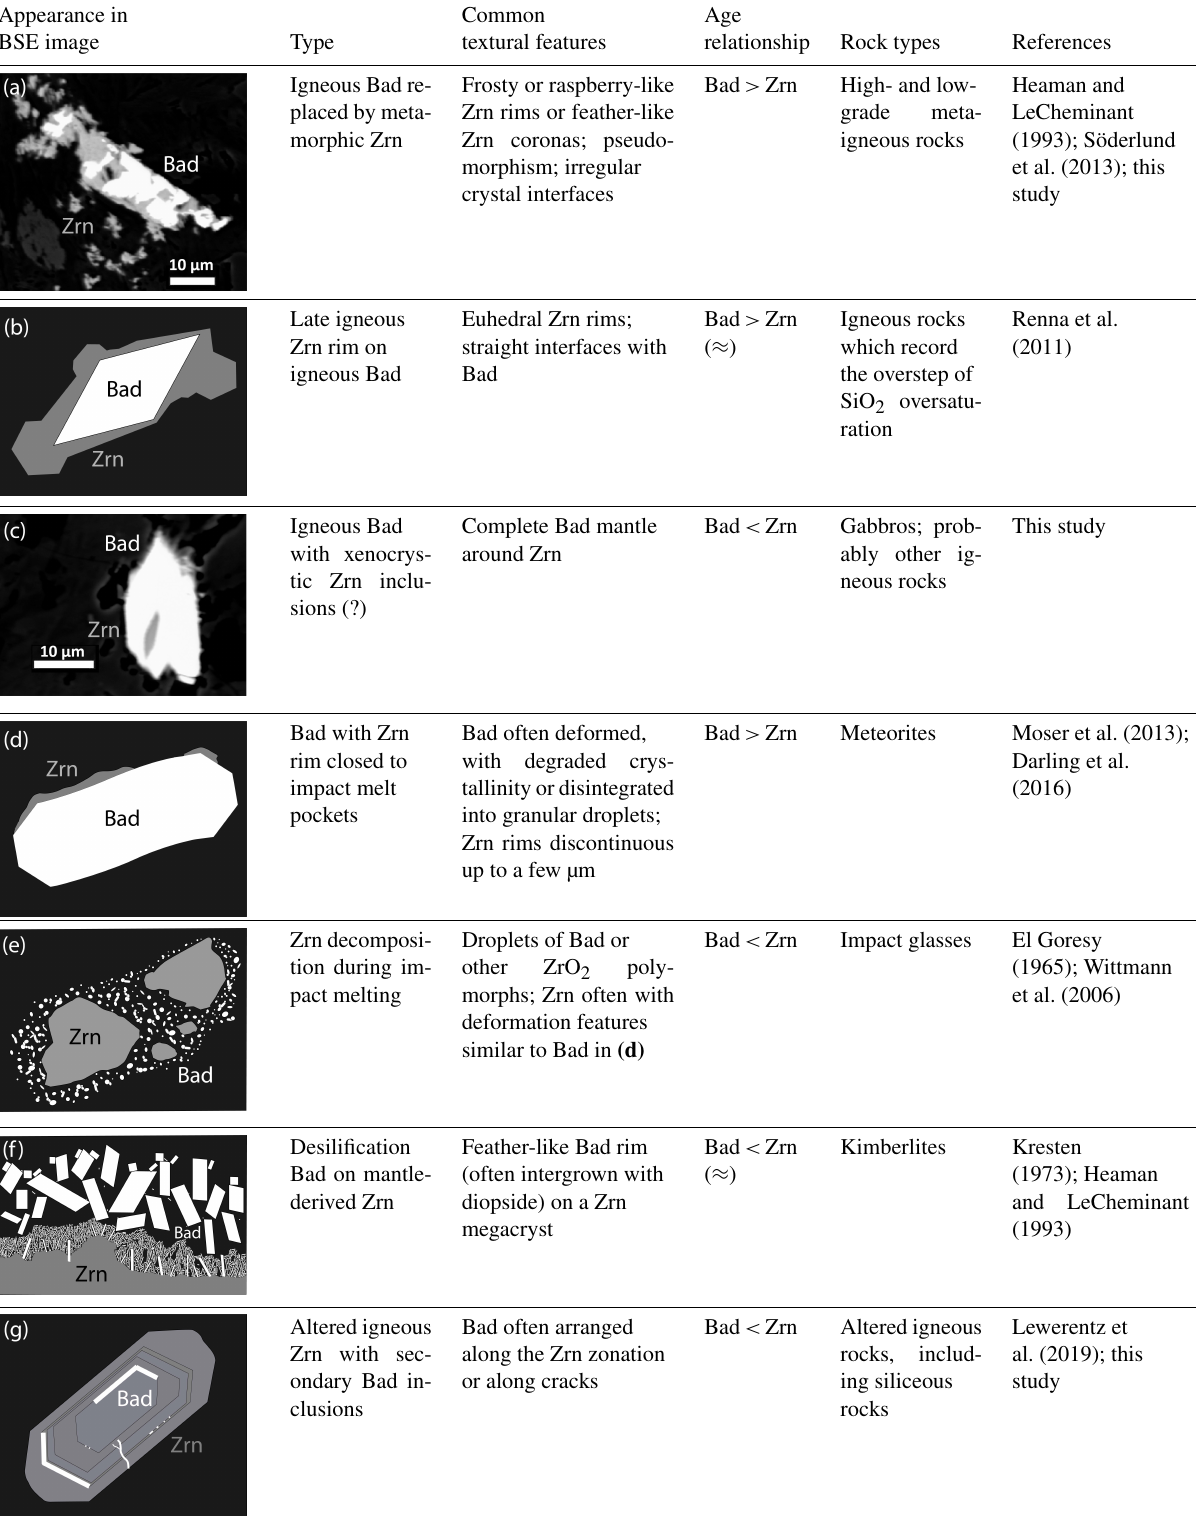
Table 4. Compilation of all known baddeleyite (Bad)–zircon (Zrn) intergrowth types and guideline for their interpretation. Appearance